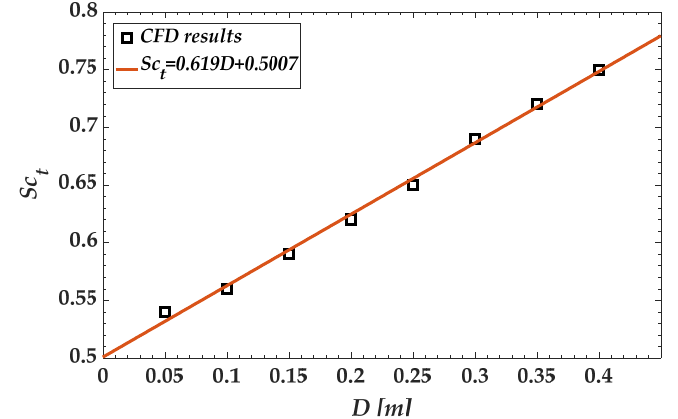
Figure 5. Relationship between valid turbulent Schmidt number and the nozzle diameter.